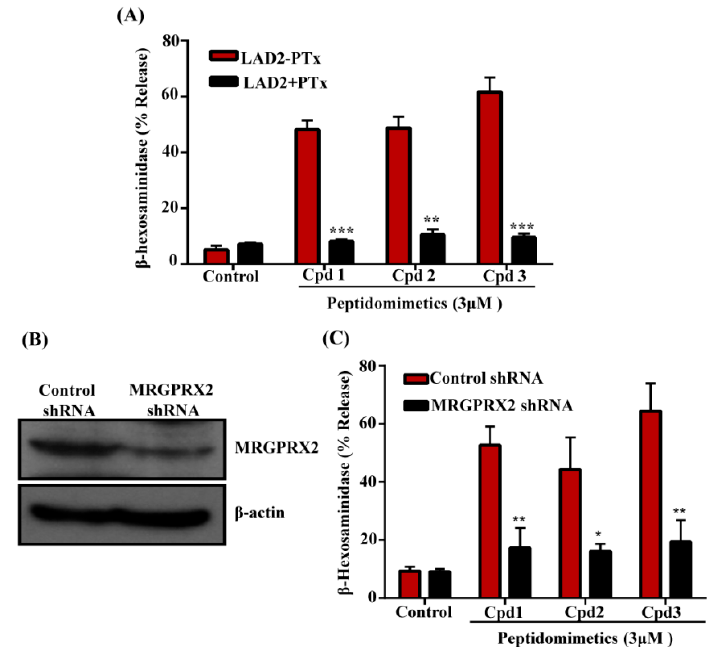
Figure 2. smHDPMs activate human mast cells via MRGPRX2. ( A ) LAD2 cells pretreated with or without pertussis toxin (PTx, 100 ng / mL, 16h) were exposed to vehicle (Control) or smHDPMs compounds (Cpd) 1, 2, and 3 (3 µ M each) for 30 min and percentage of β -hexosaminidase release was measured. ( B ) Western blotting was performed to determine the expression level of MRGPRX2 in Control and MRGPRX2 knockdown LAD2 cells. ( C ) Control and knockdown cells were stimulated with smHDPMs Cpd 1, 2, and 3 (3 µ M each) and percentage of β -hexosaminidase release was determined. All the points are expressed as a mean ± SEM of three experiments in triplicate. Statistical significance was determined by two-tailed unpaired t-Test. *** indicates p value < 0.001,** indicates p value < 0.01 and * indicates p value < 0.05.